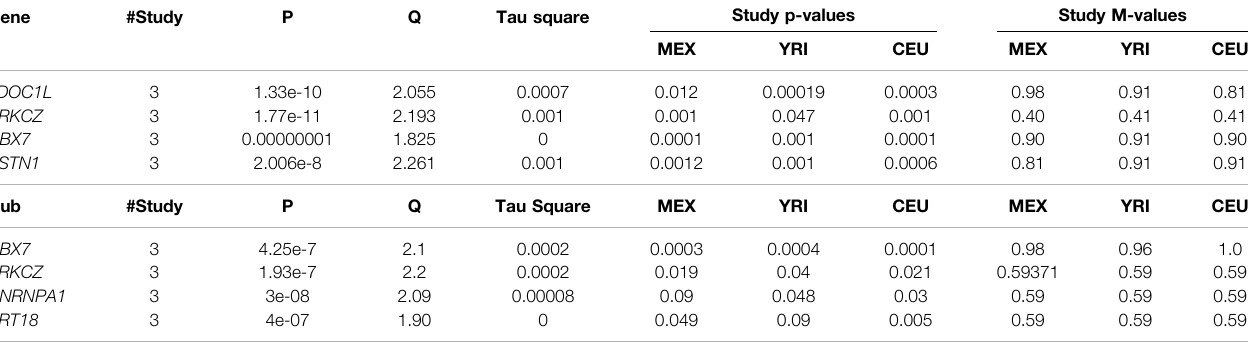
TABLE 1 | Meta-analysis at gene and subnetwork levels from the simulated GWASsummary statistics across 3studies: results show convergence ofeffects across studies to the simulated causal variants.